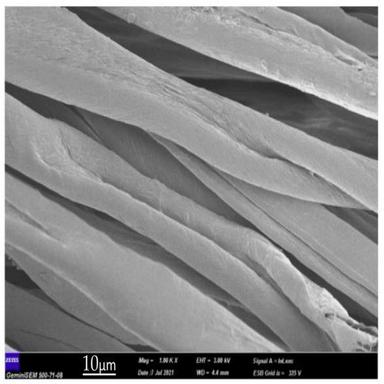
SEM images comparing undoped cotton ring spun yarns with PCM(3 %)-Cott and PCM(9 %)-Cott yarns produced at different nanocapsule concentrations and feeding rates (A: 62.5 ml/h and B: 80 ml/h) (1.00 kx).